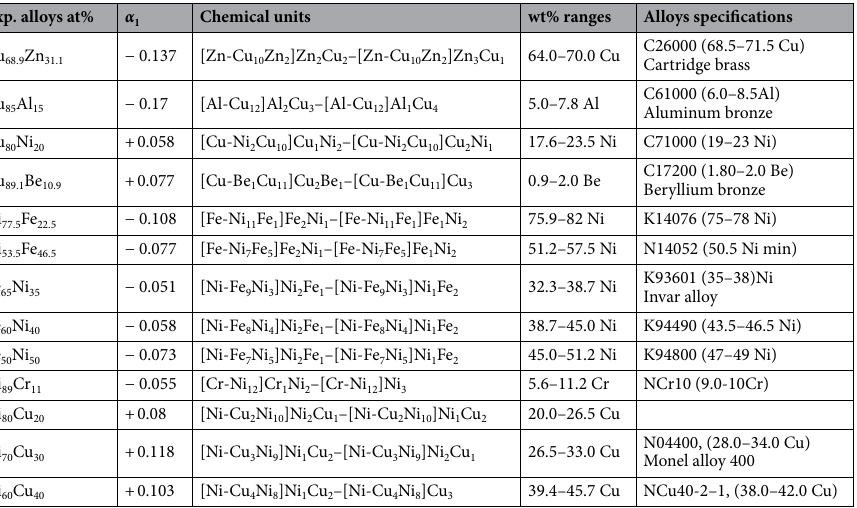
Table 1. Chemical units of typical binary solid-solution-based alloys with FCC structure, derived by combining the measured Cowley’s parameter α 1 from Refs. 17,21–26 and the cluster-plus-glue-atom model. The calculated weight percent compositions are comparable to certain alloy specifications. The grades in the table are all ASTM standard UNS numbers, except NCr10 and NCu40-2-1 which are GB/T 5235 standard of